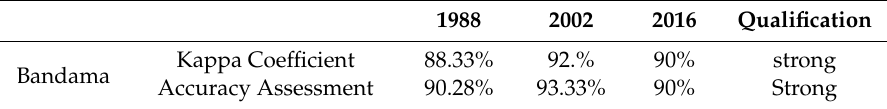
Table 3. Kappa Coe ffi cient and Accuracy Assessment of the land cover classification.